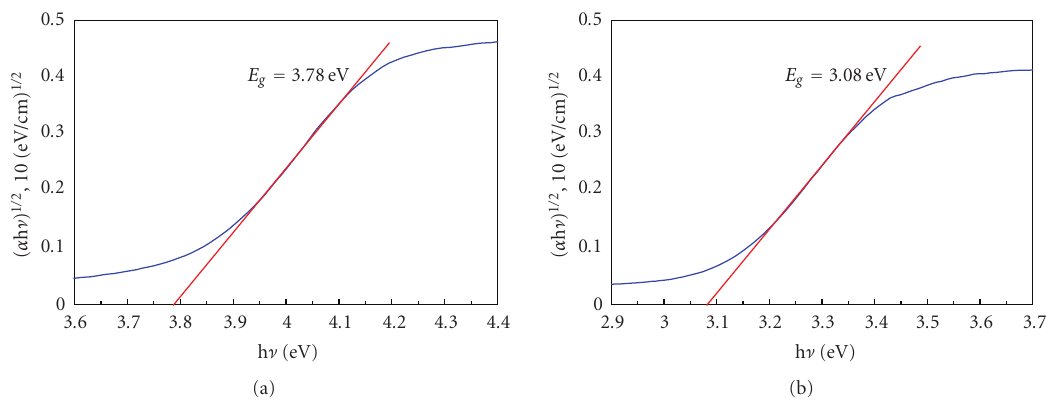
Figure 4: ( α h v ) 1 / 2 versus h v curves for the La 1 / 3 MO 3 (M = Nb, Ta) compounds: (a) La 1 / 3 NbO 3 ; (b) La 1 / 3 TaO 3 .